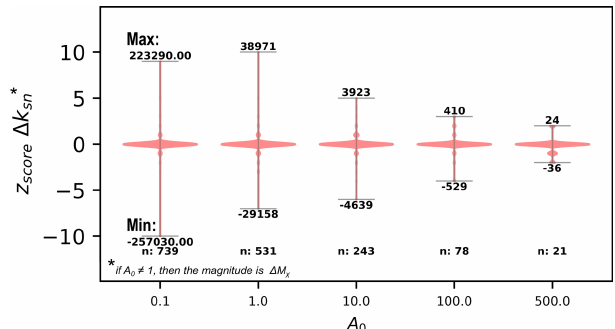
Figure 10. The effect of varying A 0 on knickpoint extraction (Eq. 3). The reference area ( A 0 ) will affect knickpoint magnitude and can be increased to reduce exaggerations in χ -elevation gra- dients. Changing A 0 does not affect the relative order of knick- points: the largest knickpoints remain the largest for all values of A 0 . Increasing A 0 , however, reduces the spread in the z score of the changes in channel steepness. This value has to be set only if nec- essary (e.g. if the high-gradient effect is important): A 0 (cid:54)= 1 implies that the magnitude is not (cid:49)k sn but (cid:49)M χ from Eq. (6). Moreover, overestimating A 0 can mask knickpoints that would be detected with A 0 = 1m 2 . The “min” and “max” stated above and below the violin plots represent the minimum and maximum (cid:49)M χ for each run.